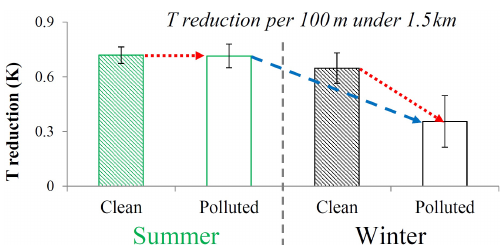
Figure 10. Average temperature reductions below 1.5km (unit: K(100m) − 1 ) from sounding observations at five cities under pol- luted (hatched bars) and clean (white bars) conditions in summer and winter. The red arrows show the change ranges from clean con- ditions to polluted conditions; the blue arrow shows the change range from polluted condition in summer to polluted condition in winter.